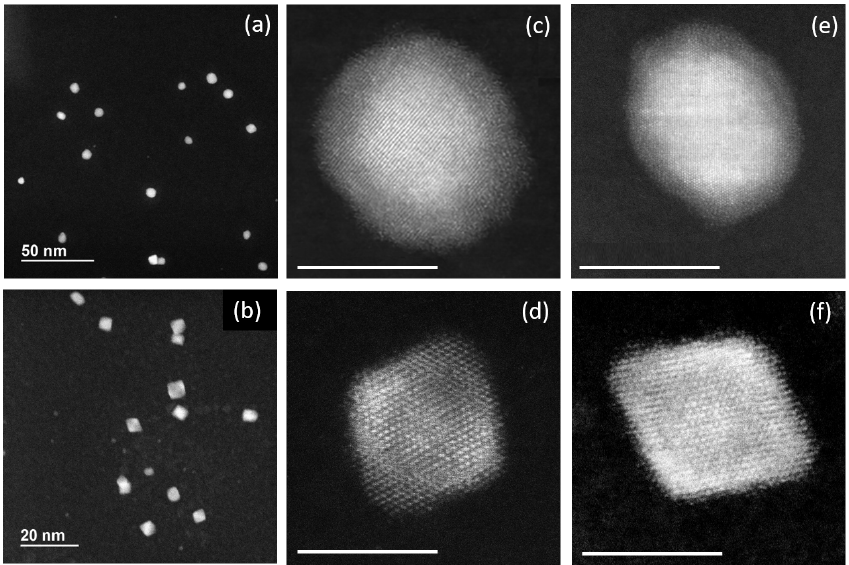
Figure 3. C s -corrected STEM-HAADF images of PtPd NPs grown in a Pd-rich atmosphere (Pd 0.8 Pt 0.2 ) ( top row ) and in a Pd-rich one (Pt 0.7 Pd 0.3 ) ( bottom row ). ( a , b ) low magnification images ( c – f ) high magnification images with scale bar—5